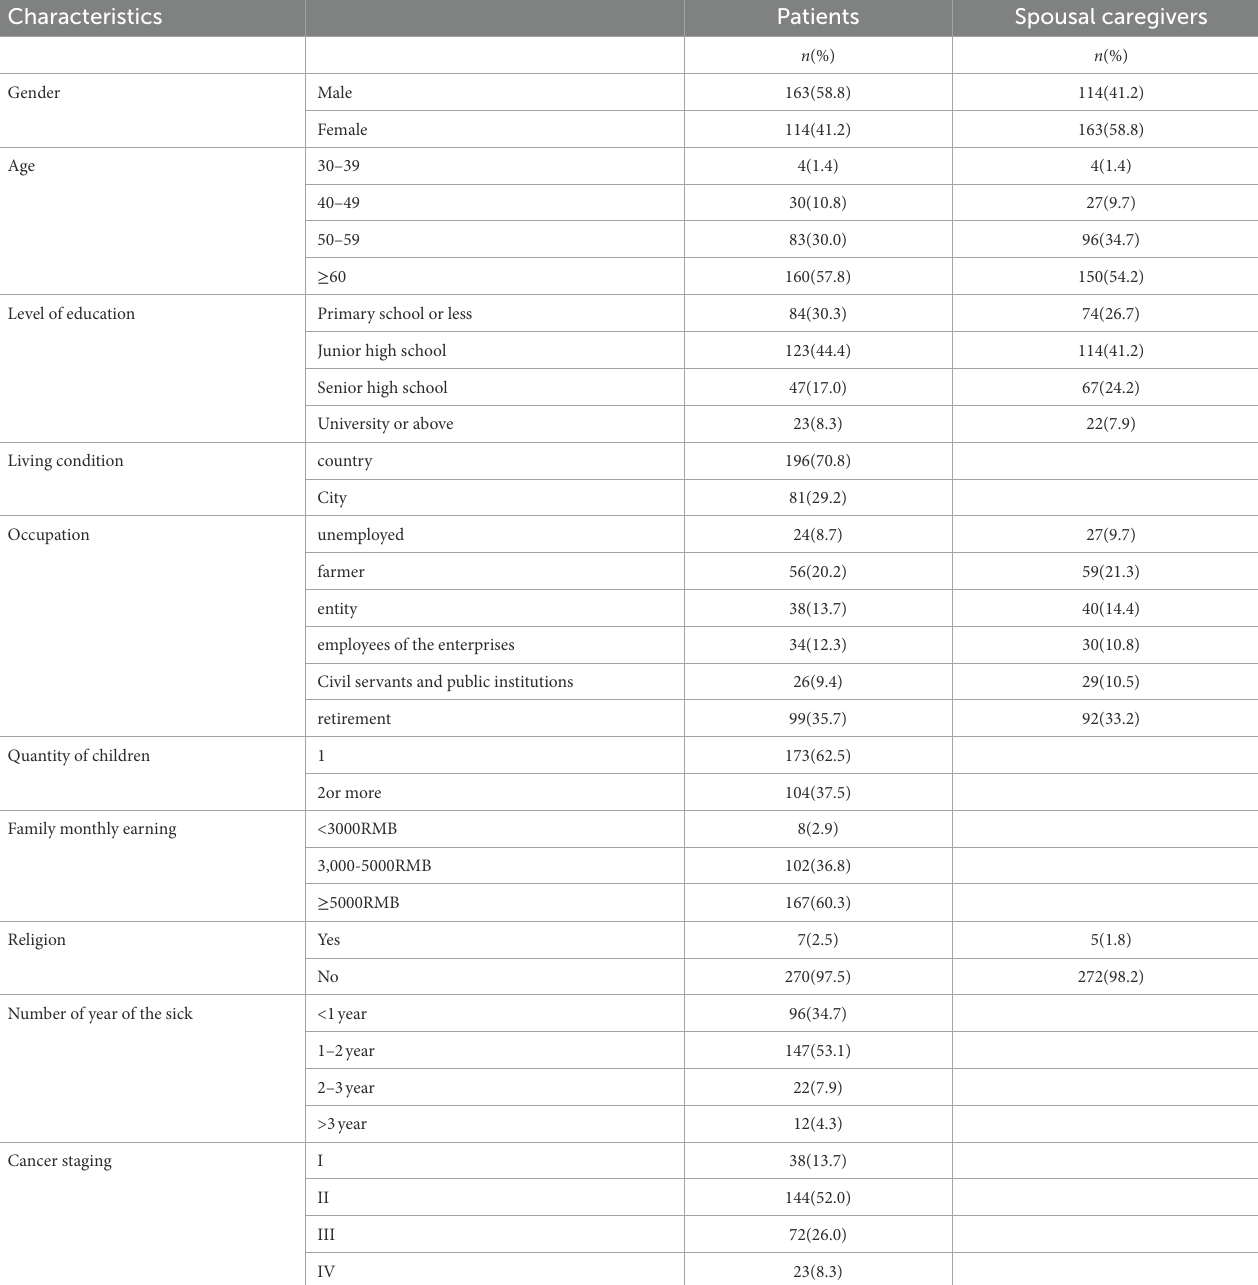
TABLE 1 Descriptive statistics of pancreatic cancer patients and spousal caregivers.